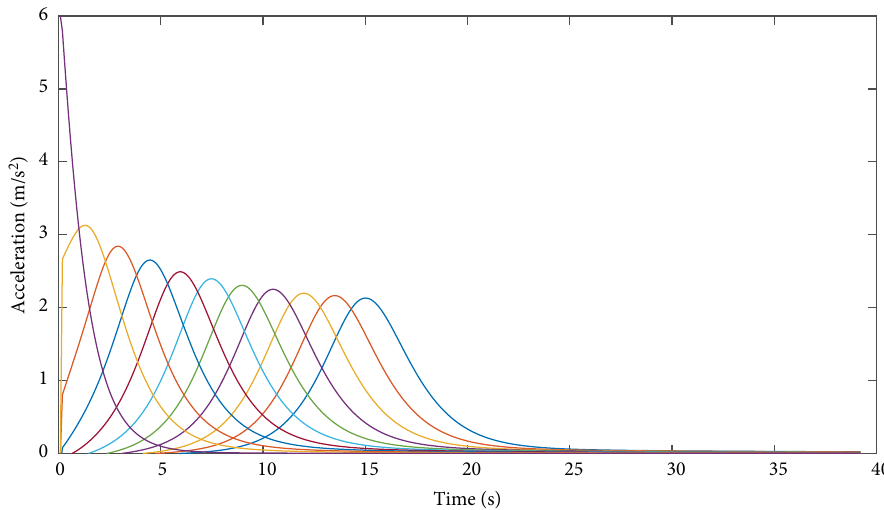
Figure 1: Acceleration of unobstructed leading vehicle and its following vehicles in AMD